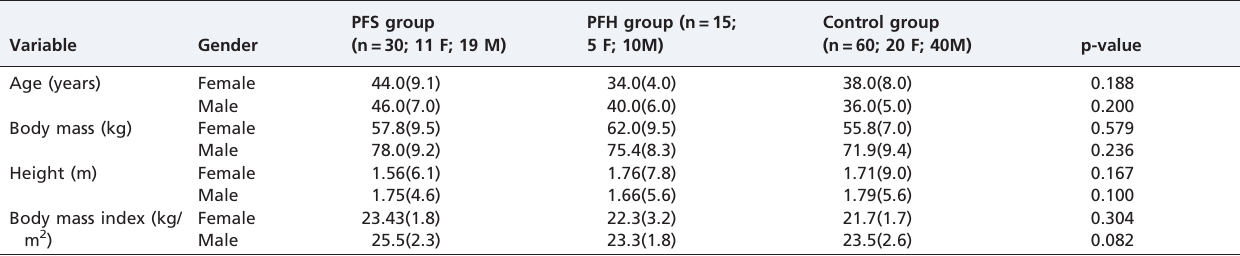
Table 1 - Descriptive statistics. Means (SD) of demographic and anthropometric